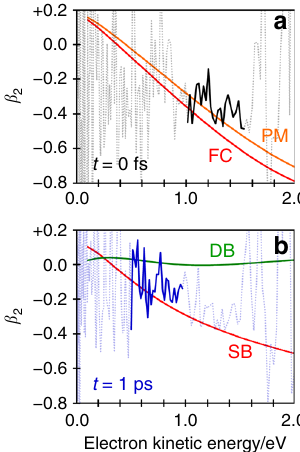
Fig. 3 Photoelectron anisotropy parameters along adiabatic coordinate. t = 0 ( a ) and t = 1 ps ( b ) with experimental (black and β 2 parameters at blue, respectively) and computed (red, orange, and green) values shown. For clarity, the region over which the experimental and computed β 2 values are comparable is highlighted in the experimental data. Dyson orbitals corresponding to the critical points on the potential energy surface are shown in Fig.